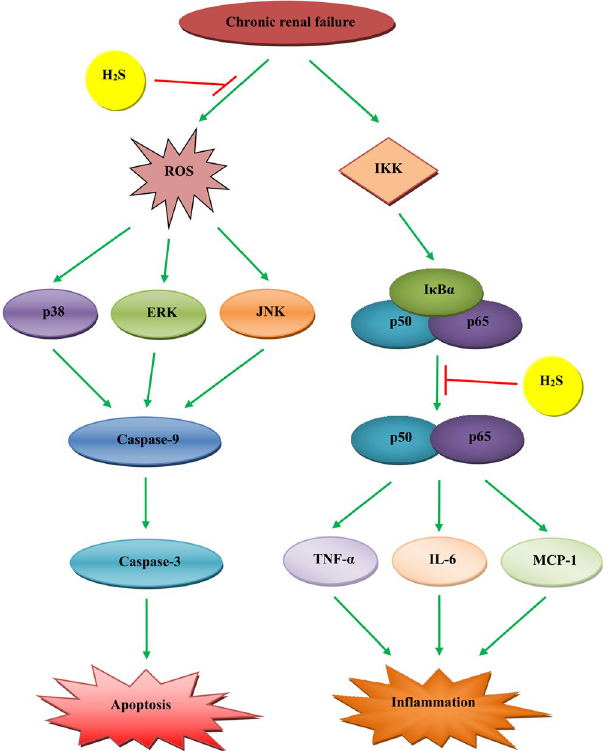
Figure 11. A schematic illustration of the role of H 2 S in ameliorating CRF. H 2 S could ameliorate CRF in rats by inhibiting apoptosis and inflammation through the ROS/MAPK and NF- κ B signaling pathways. IKK, inhibitor kappa B kinase; I κ B α , inhibitor kappa